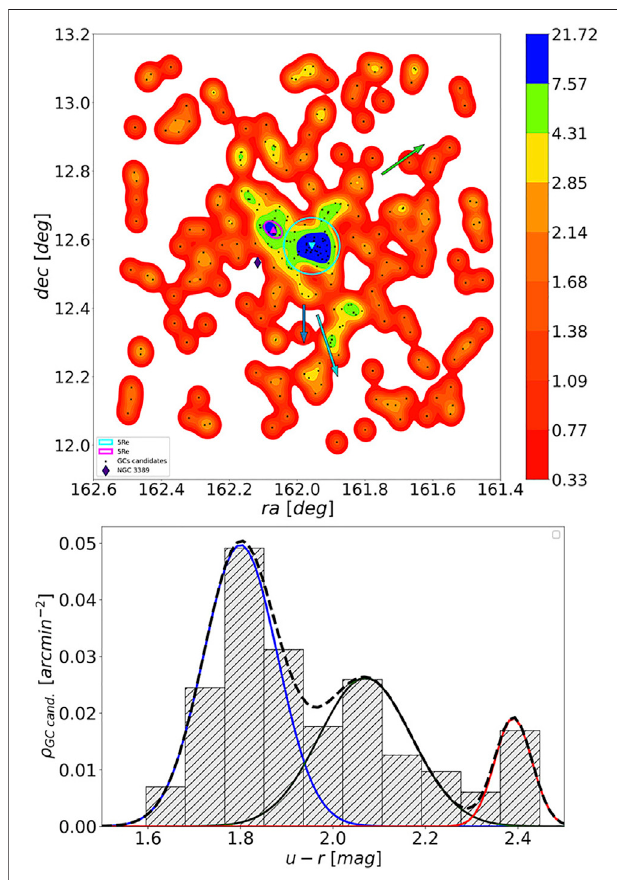
FIGURE 8 | Top panel: GC candidates 2D density map. The position of NGC3,379 and NGC3,384 are marked with cyan and magenta symbols and lines, respectively. A dark-violet diamond shows the position of NGC3,389. The green arrow shows the direction of the stream of GCs and diffuse light, aligned with the direction of NGC3,338; the dark-blue arrow shows the direction of the second stream of diffuse light; the ligh-blue arrow marks the direction of M96. Lower panel: color density distribution (corrected for background contamination, see text) over NGC3,379. The position of the blue, “ green ” and red GCs, as derived with GMM, are shown with blue, green and red (solid line) gaussians, respectively, together with the combined fi t to the entire population (black dashed